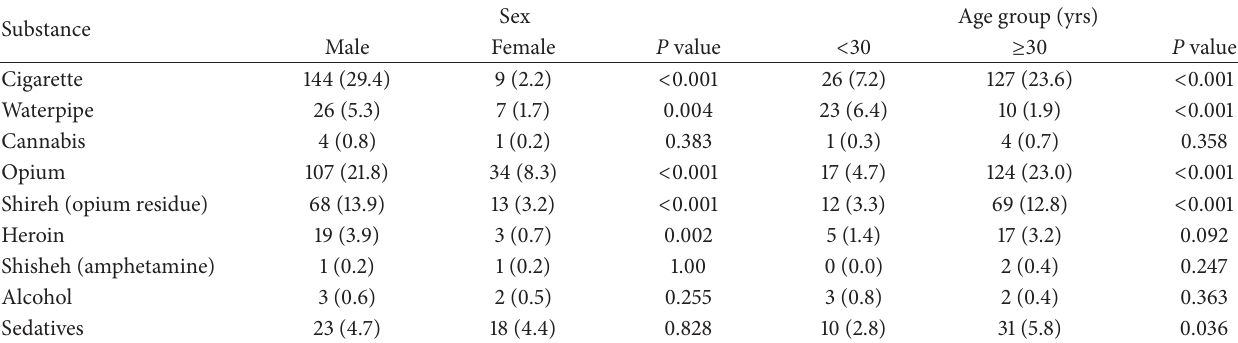
Table 3: Percentage of daily substance use among rural residents based on sex and age group ( 𝑛 = 900